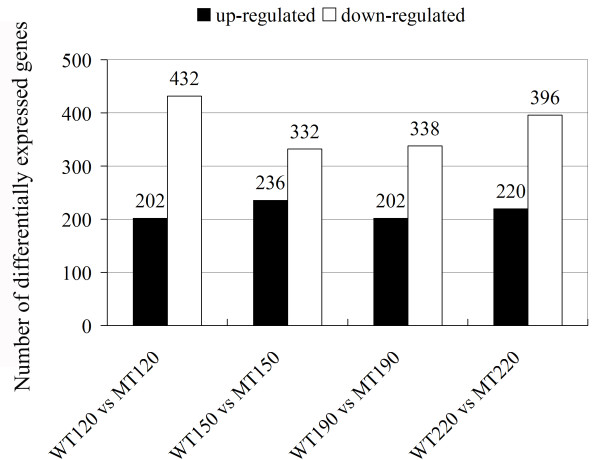
Distribution of genes differentially expressed between 'Anliu' sweet orange and its red flesh mutant at each of four selected stages of fruit development and ripening. The number of up-regulated genes was less than that of down-regulated ones at all the four stages. WT120 vs MT120 indicates a comparison between WT and MT at 120 DAF.